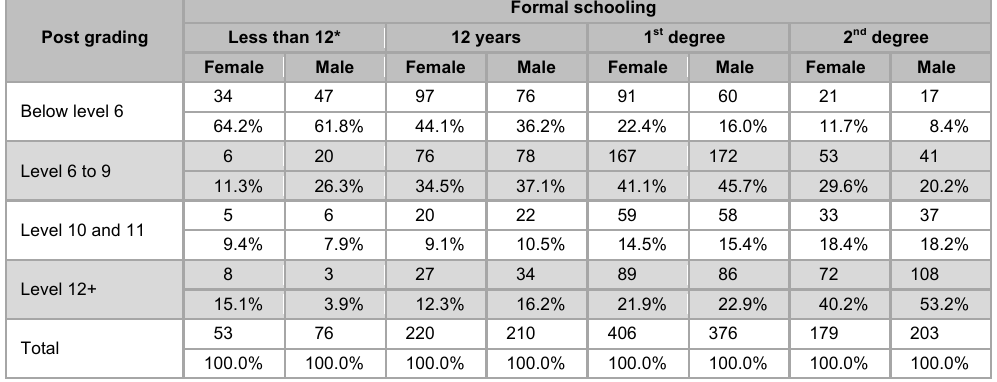
Gender and post grading according to formal schooling: cross tabulation (count data) Post grading